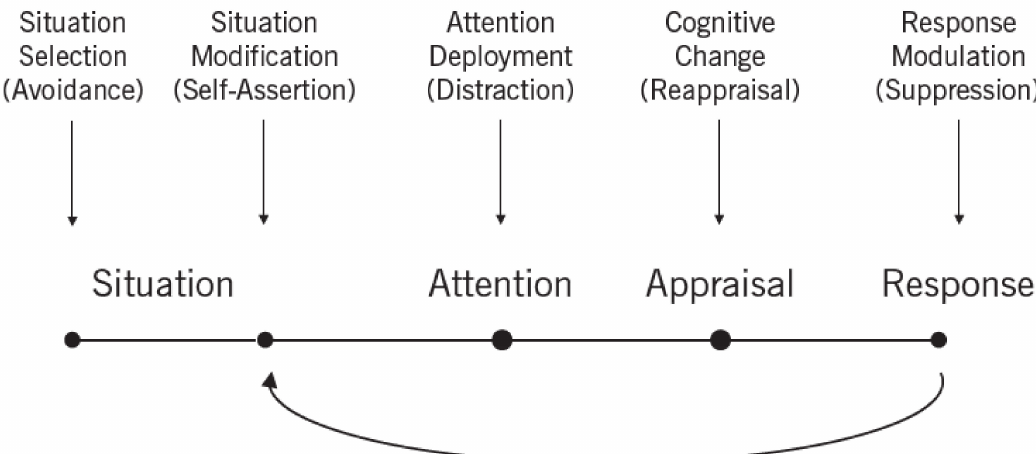
Figure 11. Schematic representation of the five-point model of processes involved in the regulation of emotions according to Gross. For any emotional event, there are a number of steps on which emotion regulation can be applied. See text for details. Slightly modified from Gross (2013)